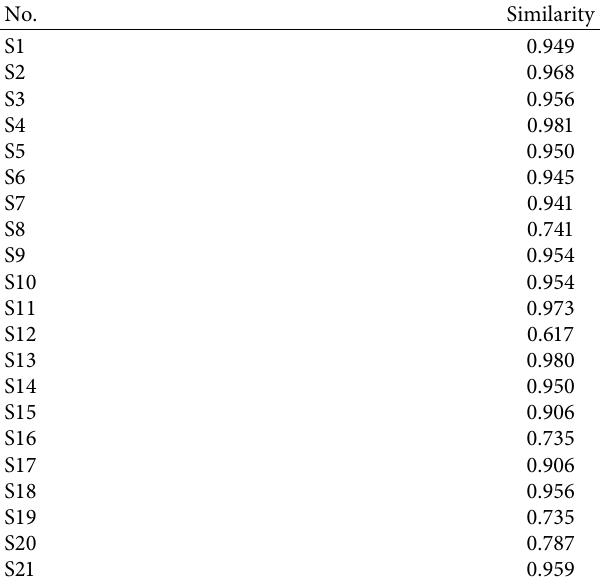
Table 3: Similarity analysis of fingerprint of total flavonoids of Glycyrrhiza uralensis Fisch. from 21 producing